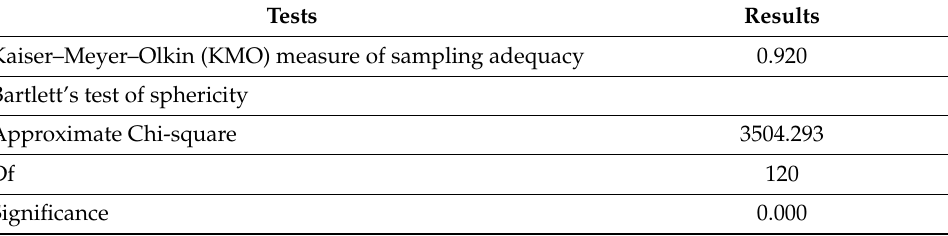
Table 1. KMO and Bartlett’s Test of EFA: KMO > 0.9 and Bartlett’s test of sphericity with the overall significance of the correlation matrix and the Chi-square value, indicating it is considered to be appropriate for EFA analysis.